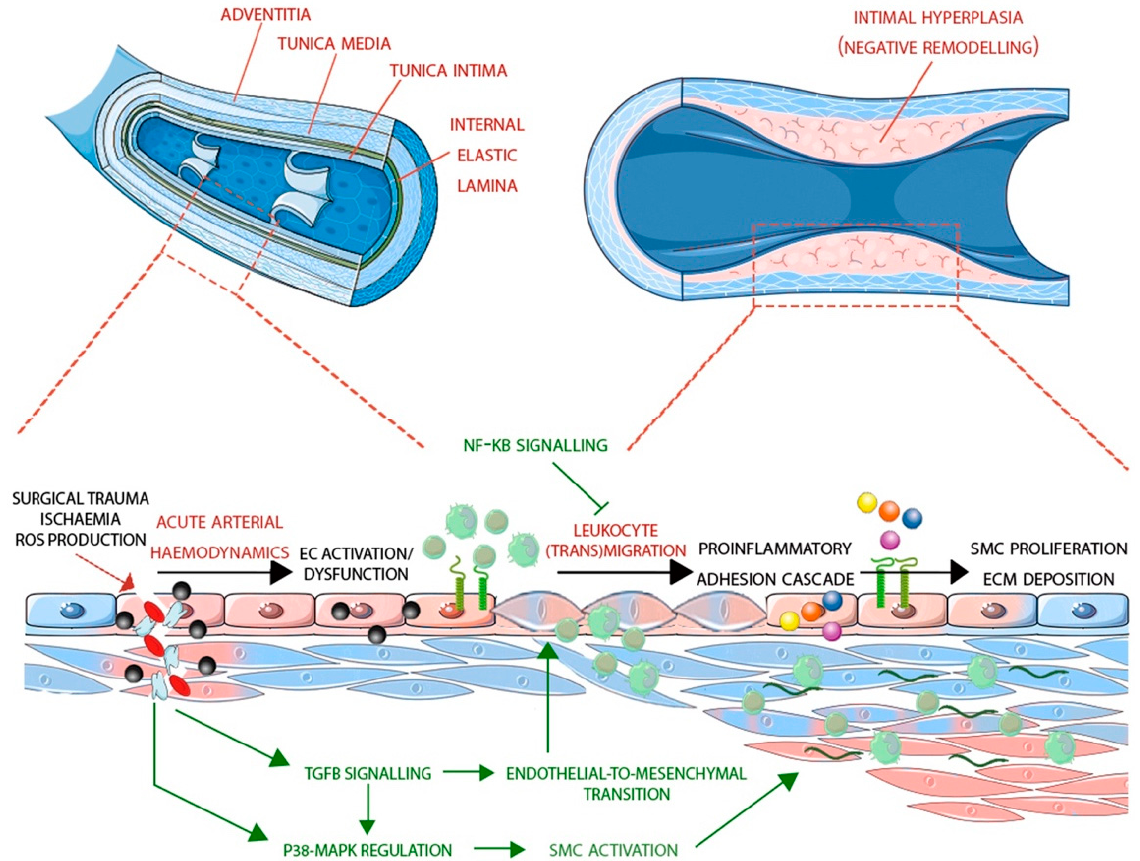
Figure 2. Overview of the onset and progression of vein graft disease, highlighting the signalling pathways implicated in the process at their location/time of induction.